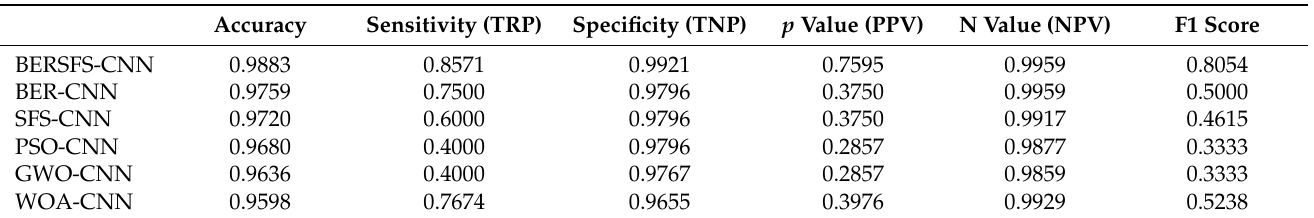
Table 11. Classification outcomes of the proposed and contrasted techniques that were based on optimizing the CNN model’s